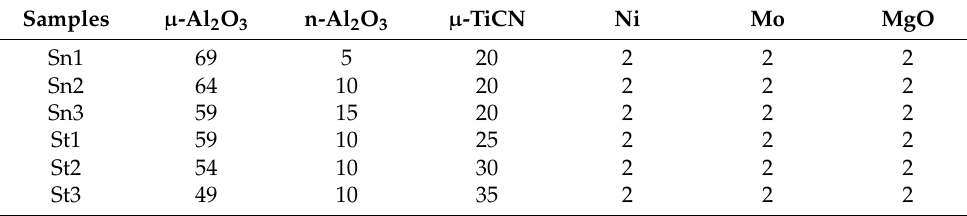
Table 1. The details of solid contents of Al 2 O 3 composite ceramic slurries (wt %). Samples